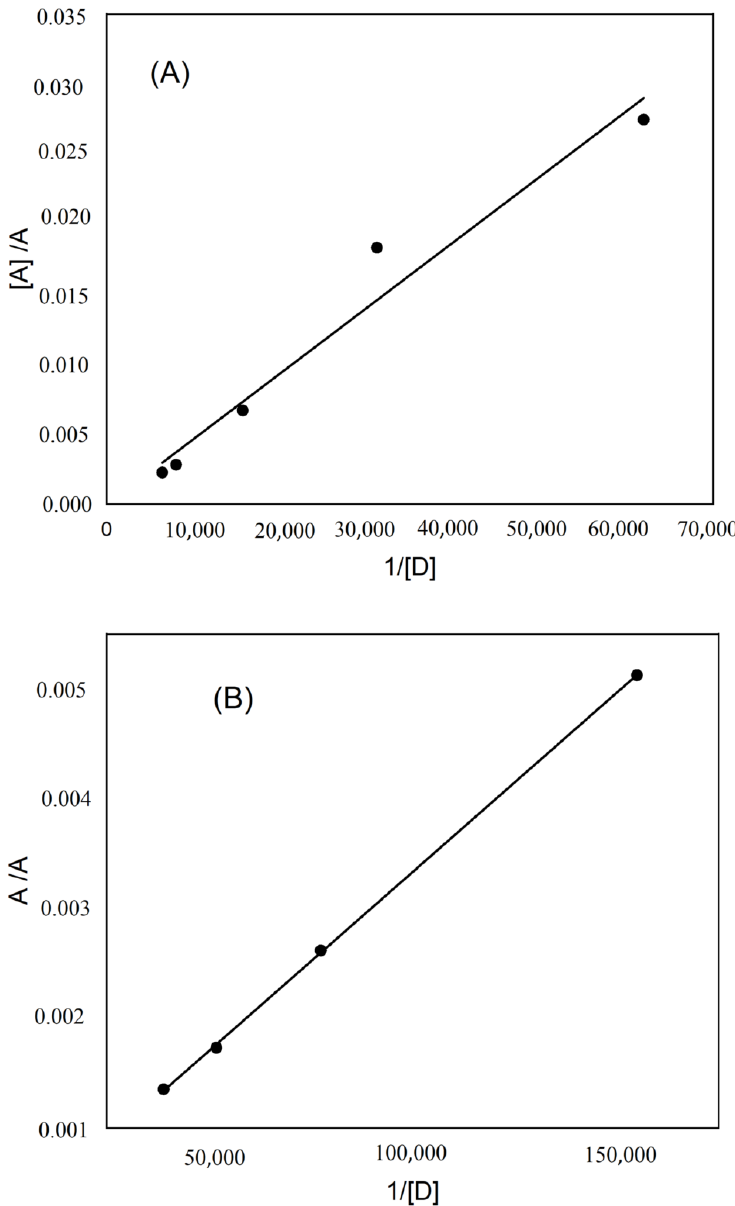
Figure 3. The Benesi–Hildebrand plot for the (A) KT-DDQ and (B) KT-TCNQ complexes.